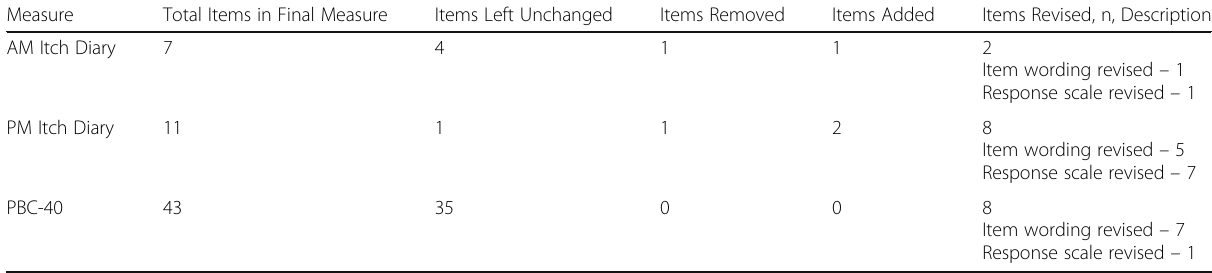
Table 6 Summary of changes to Itch Diary and PBC-40 as a result of cognitive interviews